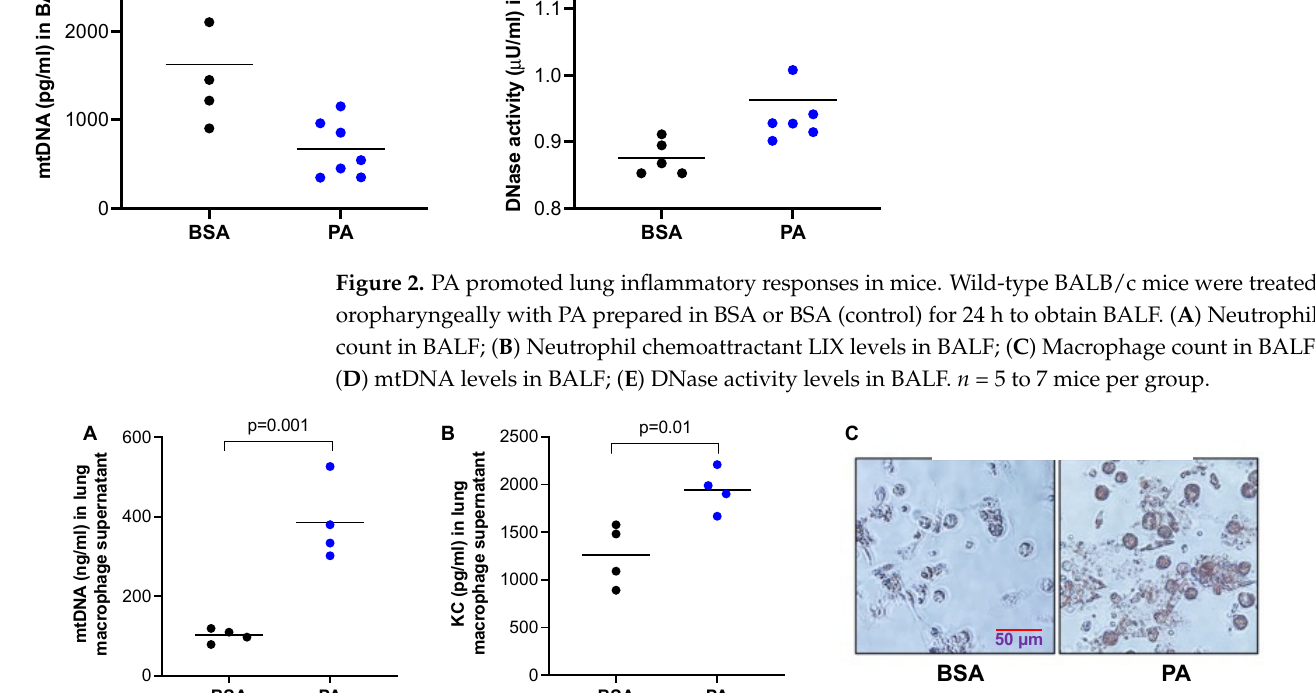
Figure 2. PA promoted lung inflammatory responses in mice. Wild-type BALB/c mice were treated oropharyngeally with PA prepared in BSA or BSA (control) for 24 h to obtain BALF. ( A ) Neutrophil count in BALF; ( B ) Neutrophil chemoattractant LIX levels in BALF; ( C ) Macrophage count in BALF; ( D ) mtDNA levels in BALF; ( E ) DNase activity levels in BALF. n = 5 to 7 mice per group. 2.3. Macrophages Stimulated with PA Increased the Release of mtDNA and Pro-Inflammatory Cytokine Production due to DNA degradation by increased DNase activity under an inflammatory milieu.